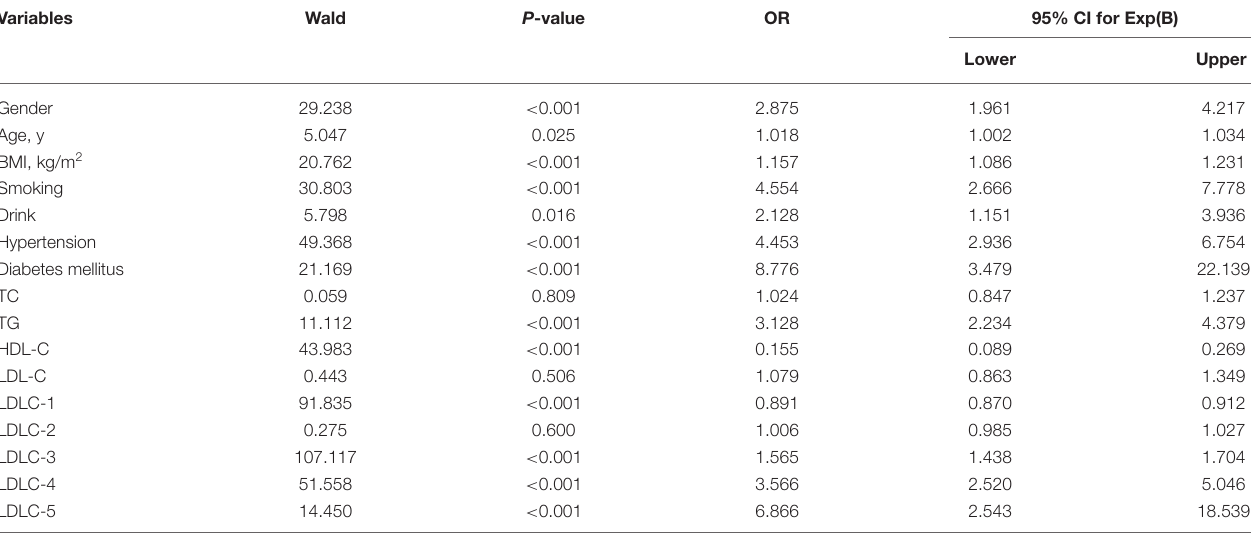
TABLE 2 | Logistic regression analysis for independent association between subjects’ variables and the risk of CAD.